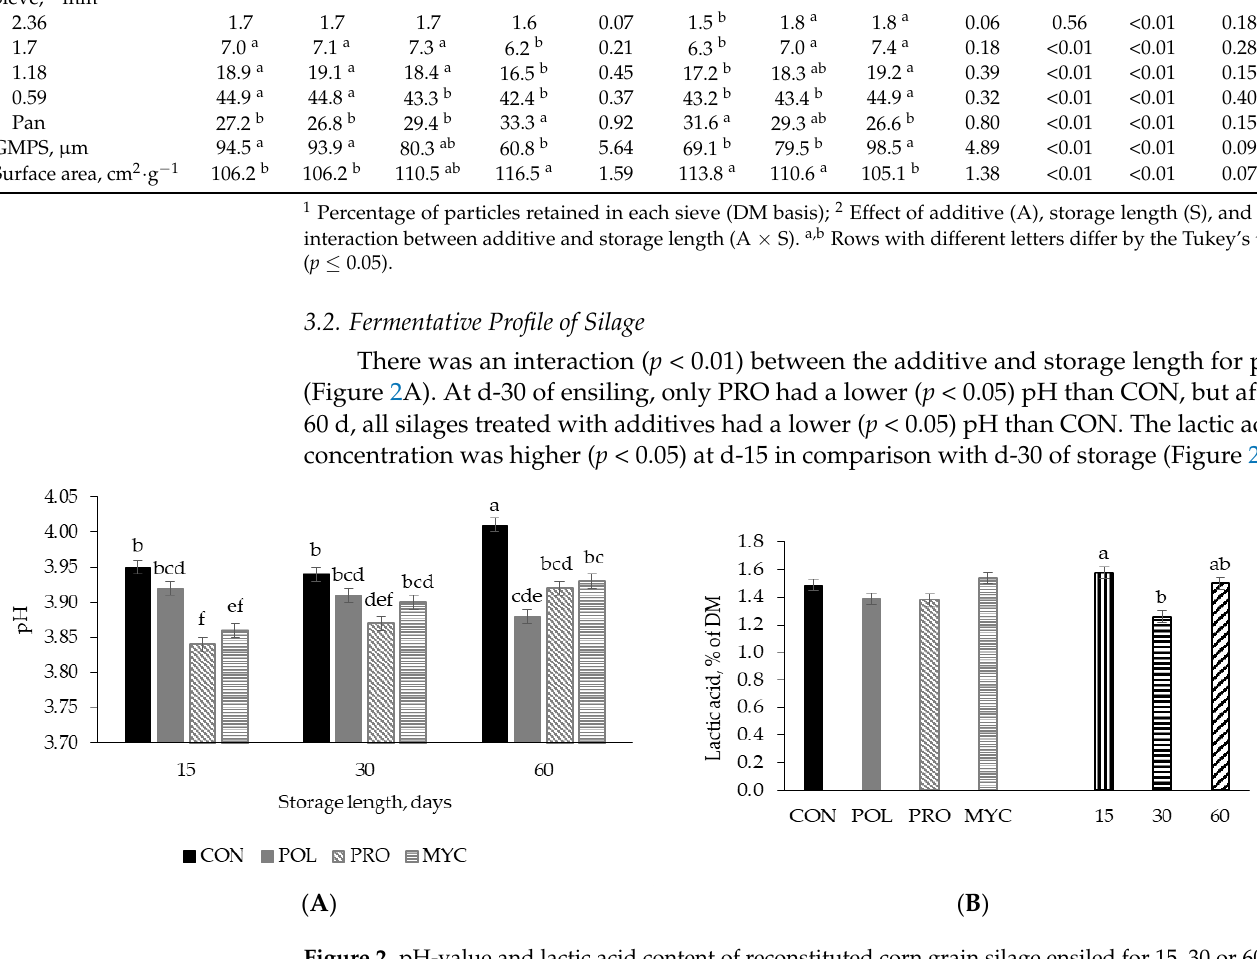
( B ) Figure 3. Acetic acid and ethanol contents of reconstituted corn grain silage ensiled for 15, 30 or 60 d, without additives treatment (CON), or treated with polysorbate 80 (POL), propionic acid (PRO) or polysorbate 80 and propionic acid (MYC). Statistical effects observed for ( A ) Acetic acid – Addi- tive, p < 0.01, SEM = 0.004; Storage, p < 0.01, SEM = 0.003; A × S, p = 1.00; ( B ) Ethanol – Additive, p < 0.01; Storage, p < 0.01; A × S, p < 0.01, SEM = 0.02. Different letters differ by Tukey’s test ( p ≤ 0.05) . As expected, the propionic acid concentration was higher ( p < 0.05) in silages treated with additives that contained propionic acid (PRO and MYC) than for those treated with CON and POL, at all lengths of storage analyzed (Figure 4A). A treatment vs. storage length interaction ( p < 0.01) was observed for the butyric acid content. All silages stored